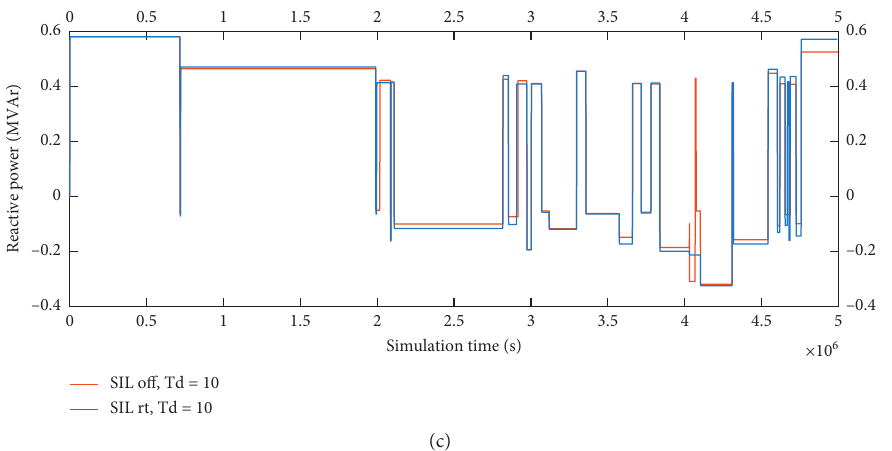
Figure 13: Results of the offline SIL and real-time SIL simulations. Reactive power flow of the WTconverter when T The RPW controller was set up to the TSO limits of ± 50 kVAr, except QD 1 � Q i +200 kVAr.